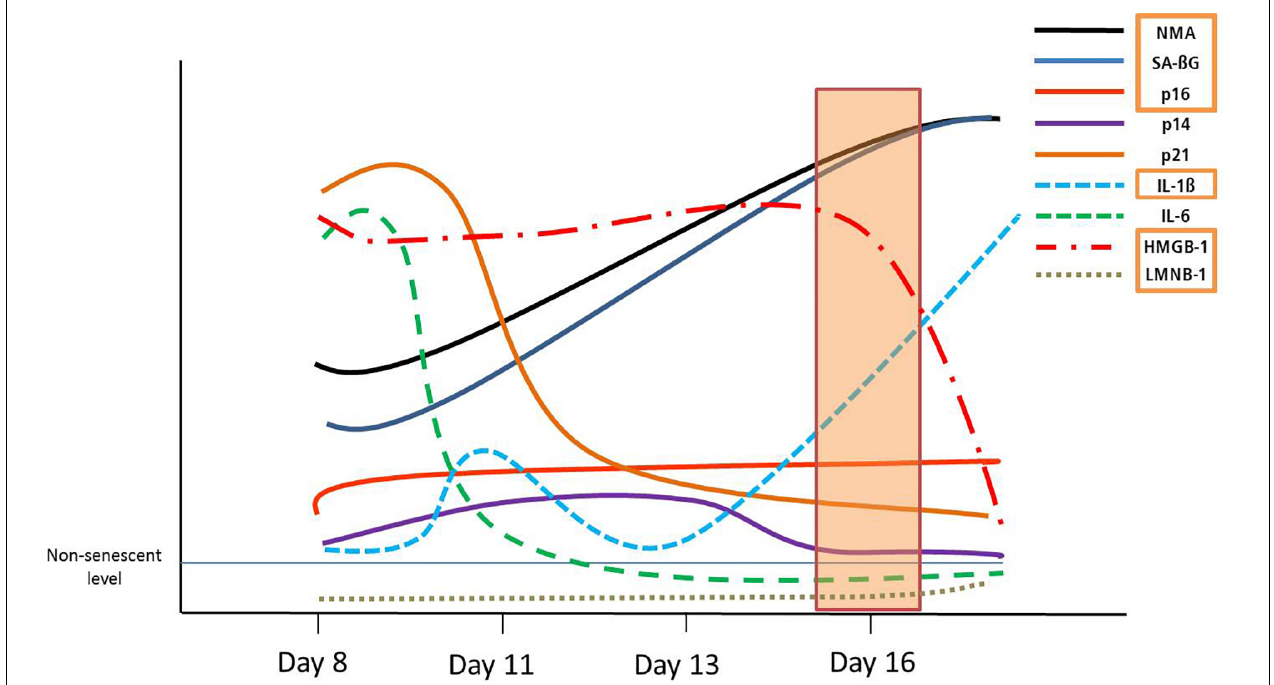
FIGURE 5 | Graphical summary of the dynamic development of senescence markers in DS. Orange rectangles signify markers shared with RS, from day